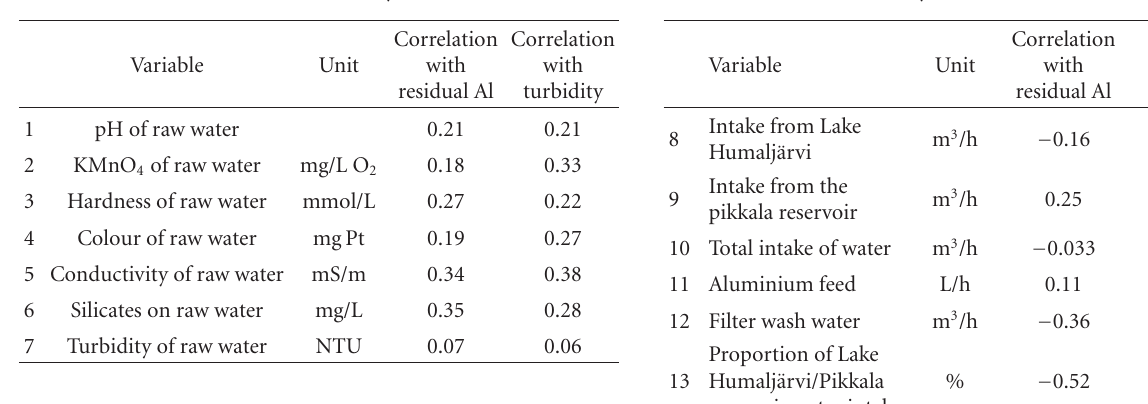
Table 1: Raw water variables used for modelling and their correlations with residual Al and turbidity.